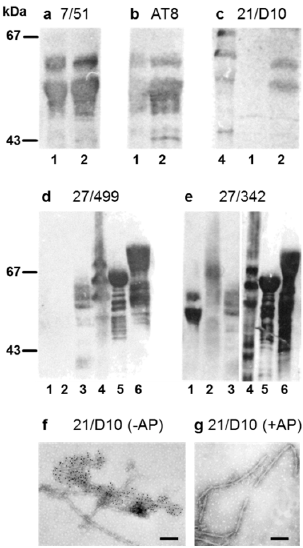
Figure 1. Immunoreactivity profile for tau antibodies. ( a ) The mAb 7/51 recognised tau proteins isolated from the brain of neonatal rat both before (lane 1; NT) and after (lane 2; NTP) hyperphosphorylation in vitro ; ( b ) The mAb AT8 recognised endogenously phosphorylated tau (lane 1), the extent of which is increased following further in vitro phosphorylation (lane 2); ( c ) The